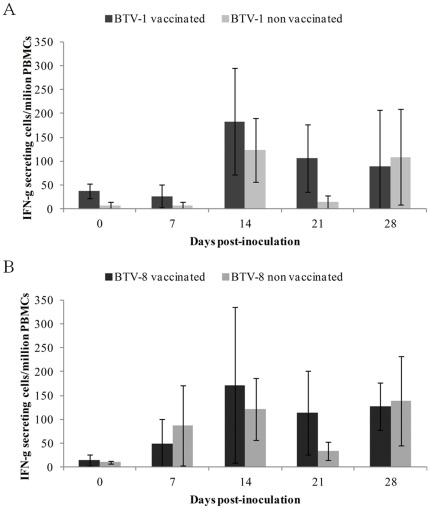
Interferon-gamma spot numbers produced by PBMCs after stimulation with the homologous strains.Mean with standard deviation of IFN-γ expression in 106 PBMCs stimulated after challenge with BTV-1 (A) and BTV-8 (B). Counting of spots of the negative control has been substracted from each sample.